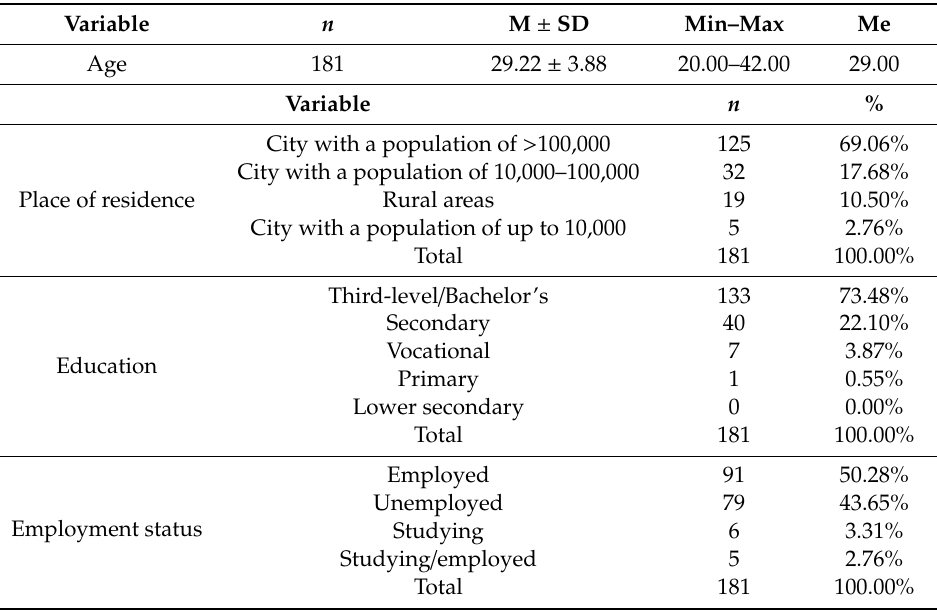
Table 1. Sociodemographic